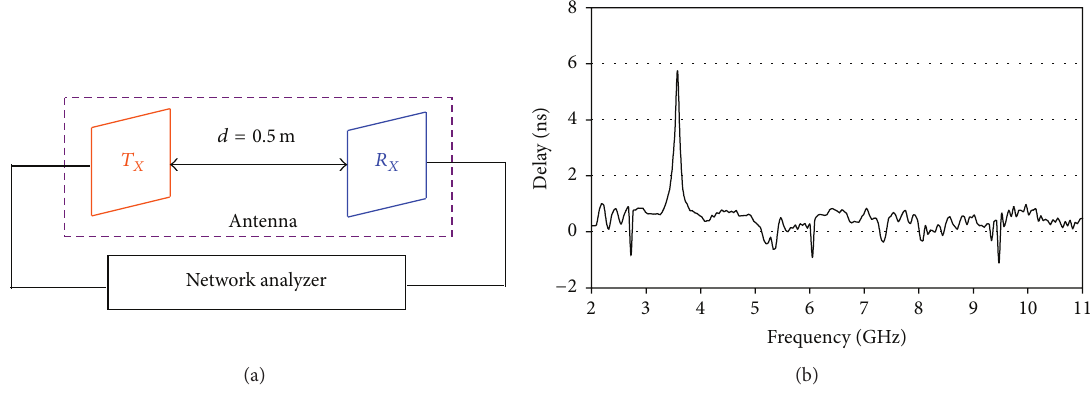
Figure 10: (a) Measurement setup and (b) measured group